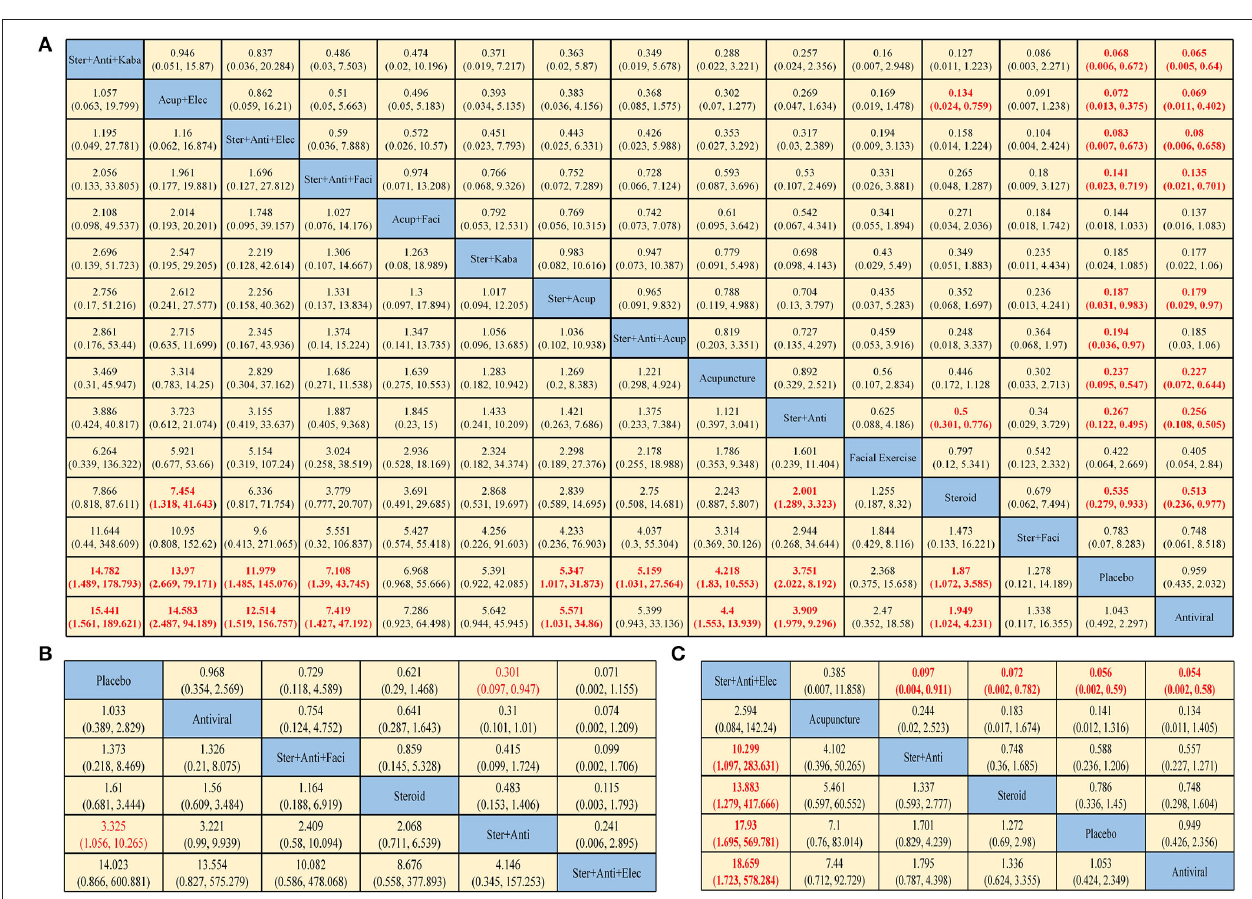
Frontiers in Neurology | www.frontiersin.org